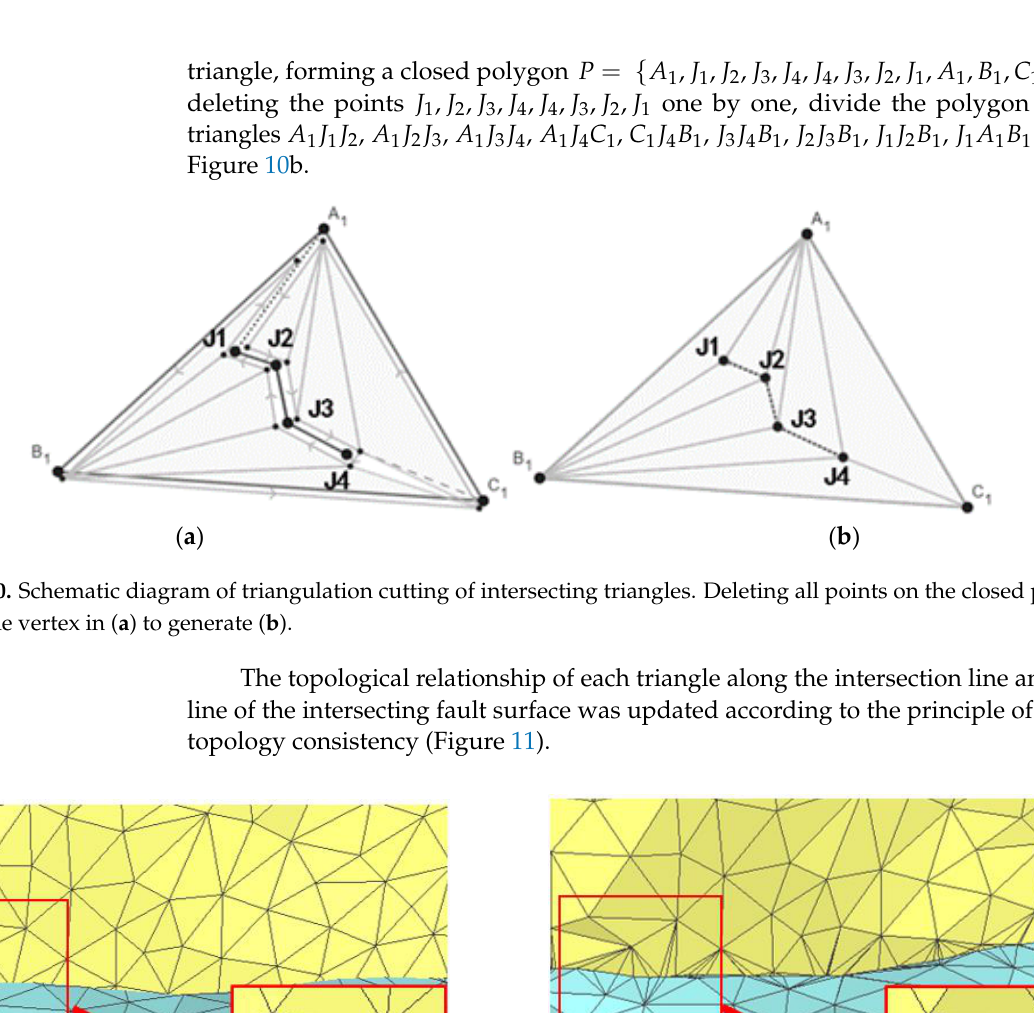
( c ) Figure 9. Schematic diagram of three kinds of triangle closed polygon. ( a ) has two points at the edge. ( b ) has one point at the edge. ( c ) has all points inside the triangle. After the closed polygon Pc is constructed, traverse and delete the points on the closed polygon to generate new triangles until all new triangles are generated by segmen-